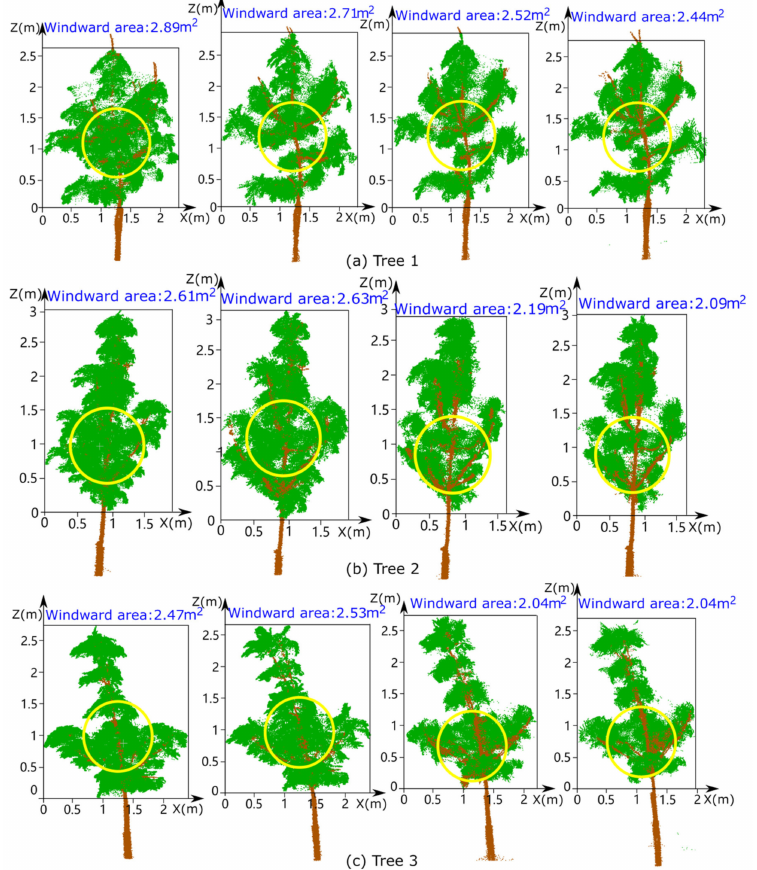
Figure 9. The windward area of each rubber tree under various wind hazards. ( a – c ) represent Tree 1 (closest to the fan), Tree 2 (the middle tree), and Tree 3 (farthest from the fan), respectively, and the yellow circle represents the corresponding position of the forced draft fan in the current view. The columns from left to right represent the variations of windward area corresponding to different wind velocities, i.e., 4.6 m/s, 10.5 m/s, 13.5 m/s, and 17.5 m/s,